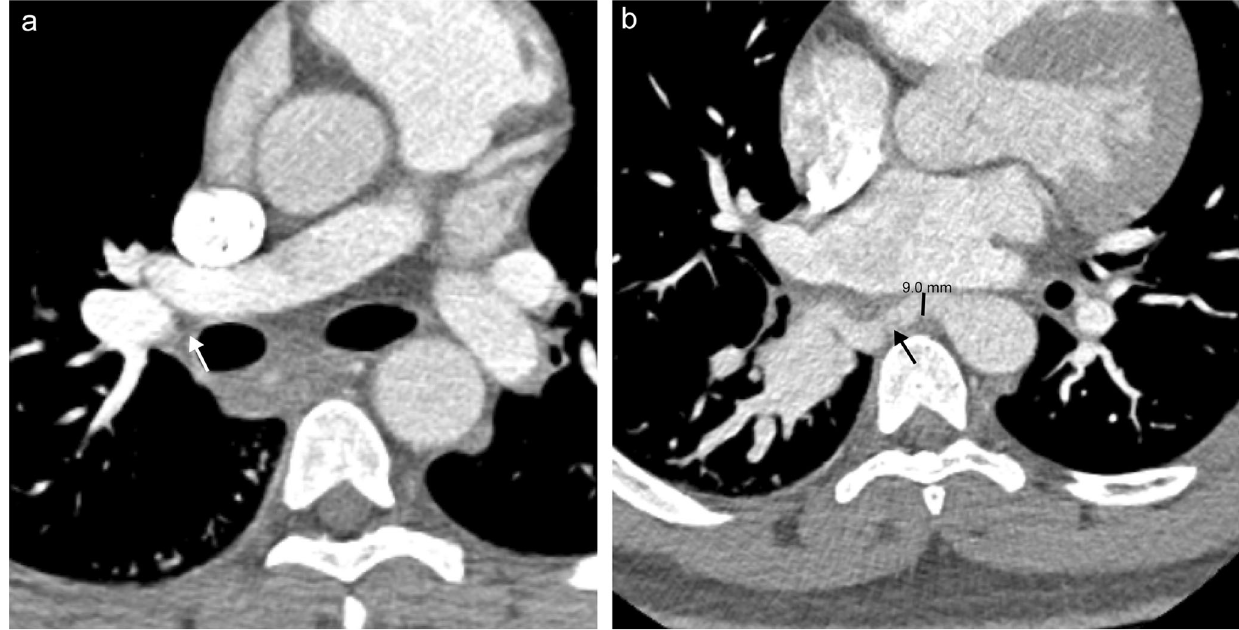
Fig. 20 Bronchial artery dilatation. a Axial CT image showing congenital absence of the right lower lobe pulmonary artery ( white arrow ). b Axial CT image showing 9.0 mm dilated bronchial artery supplying the right lower lobe ( black arrow )